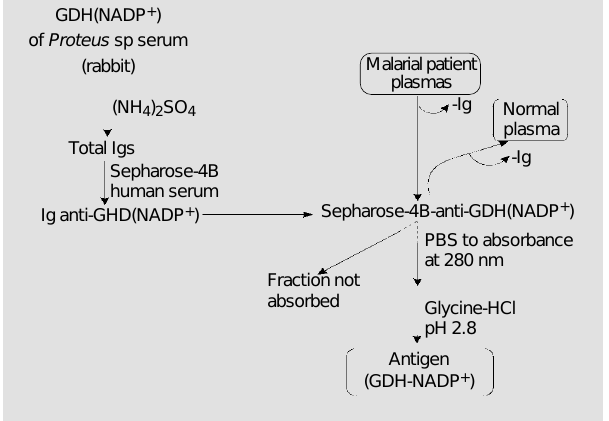
Figure 1 - Procedure for the separation of GDH(NADP + ) from malarial patient plasmas by affinity